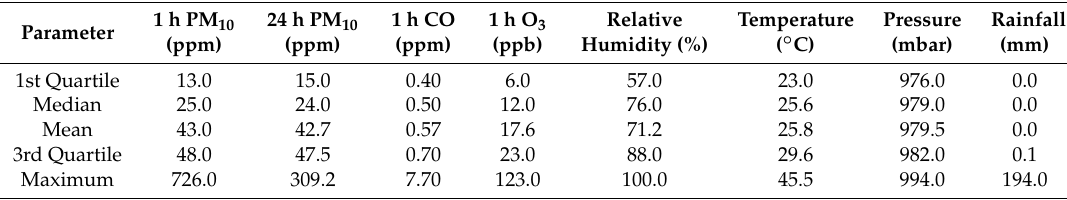
Table 1. Statistical records of air pollution and meteorological data in Mae Hong Son Province (2009–2017). PM 10 : particulate matter less than 10 µ m in